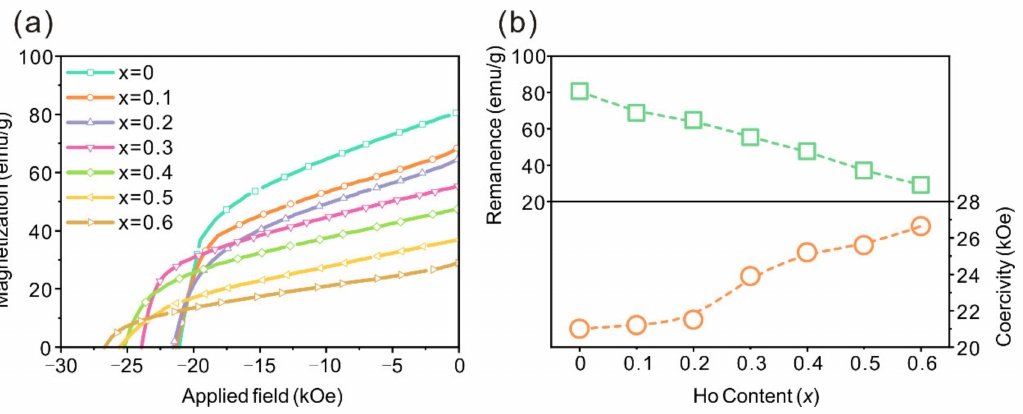
Figure 2. ( a ) Demagnetization curves and ( b ) the corresponding magnetic properties of the NPHFBM alloys at 300